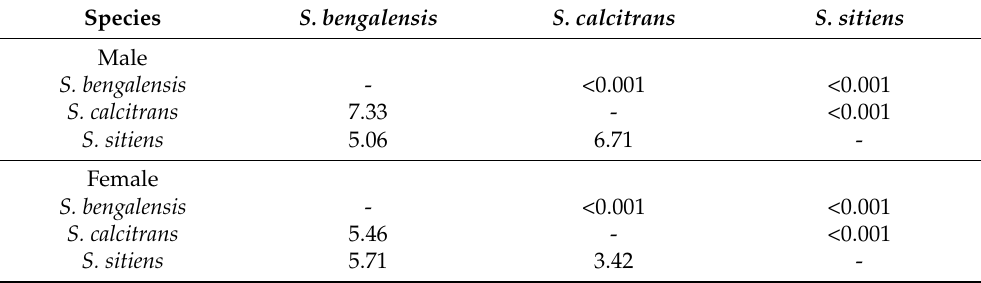
male and female Stomoxys bengalensis , S. calcitrans , and S. sitiens